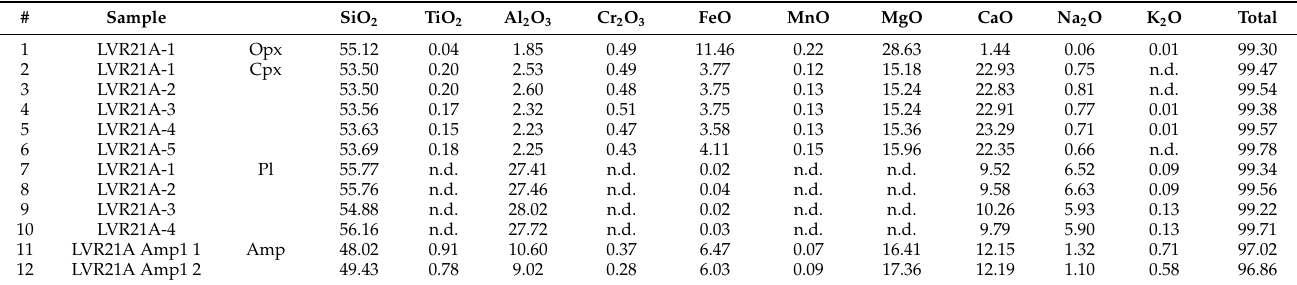
Figure 10. ( a , b ). BSE images of corona-type texture in a plagioclase-bearing orthopyroxenite of the Lyavaraka complex (Figure 6e). The symbols are: Opx for orthopyroxene, Cpx for clinopyroxene, Amp for amphibole, and Chr for chromian spinel. The myrmekite-type shell consists of amphibole with micrometer-sized inclusions of quartz (black). The sample location (LVR-21a) is shown in Figure 5. Table 6. Compositions of minerals in a Pl-bearing orthopyroxenite with a corona-type texture in the Lyavaraka ultrabasic complex, Kola